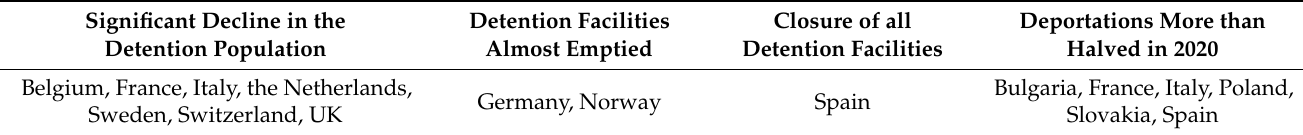
Table 1. European jurisdictions particularly affected by coronavirus-related immigration enforcement changes. Significant Decline in